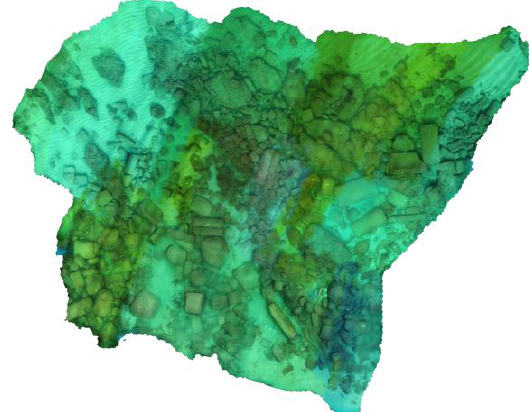
Figure 8. Orthophoto before preprocessing of the raw images showing the different visibility conditions of 2014